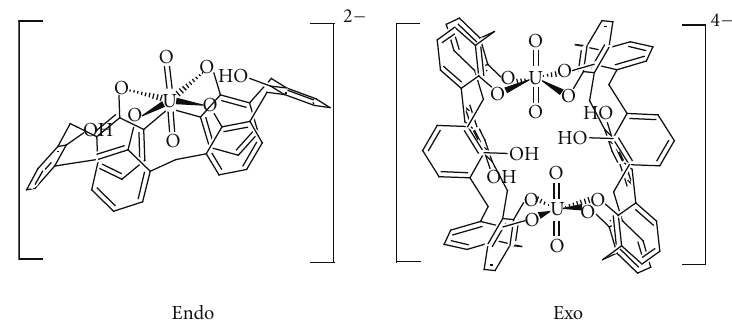
F 2: Endo- and exocavity binding in